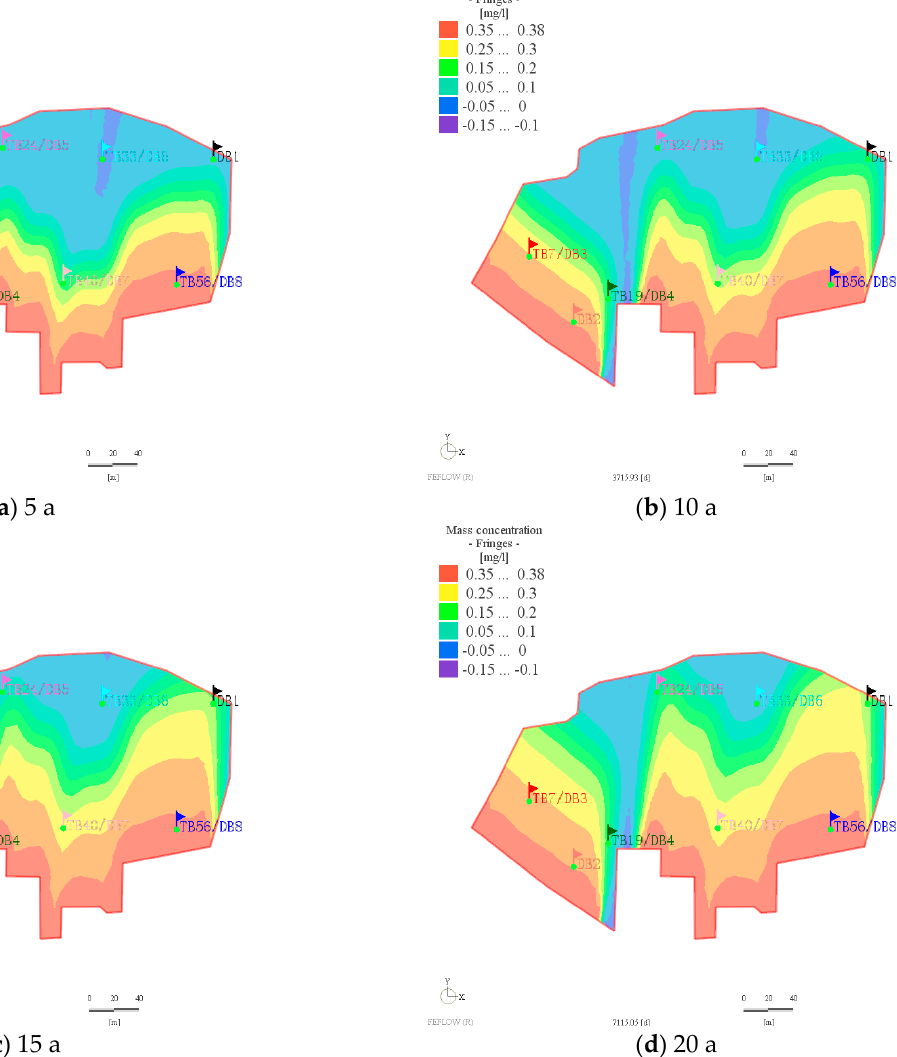
Figure 7. Pollutant transport in the simulation area: change of pollutant concentration in groundwater during ( a ) 5, ( b ) 10, ( c ) 15 and ( d ) 20 years.